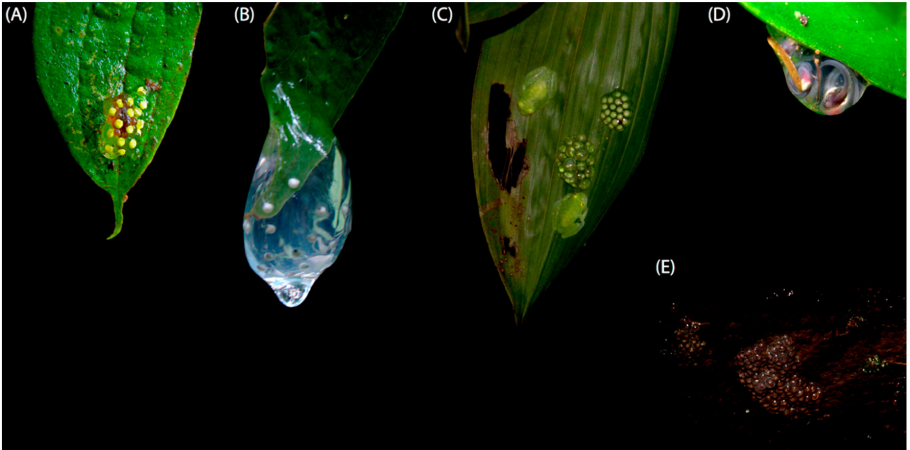
Figure 4. Egg deposition sites in glassfrogs. ( A ) On upper side of leaves ( C. sanchezi) . ( B ) On tip of leave ( N. wileyi) . ( C ) On underside of leaves ( H. cappellei , photo by C. Barrio-Amor ó s). ( D ) On the margin of underside of leaves ( Teratohyla spinosa , photo by R. Puschendorf). ( E ) On rocks (e.g., Sachatamia albomaculata , photo by R. Puschendorf). Figure modified from Guayasamin et al.